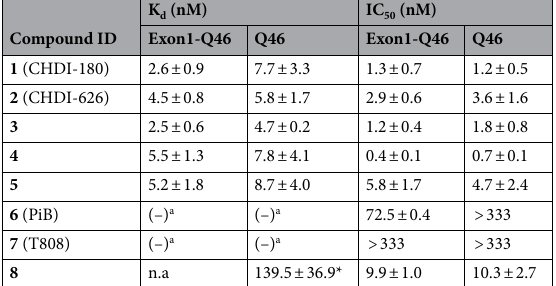
Table 1. Binding and competition potencies in RBA. Mean values and standard deviations; see structures of compounds in Supplementary Fig. S1. *Higher protein concentrations (10–30 µM) were applied. a Not determinable because TB NSB. ≅